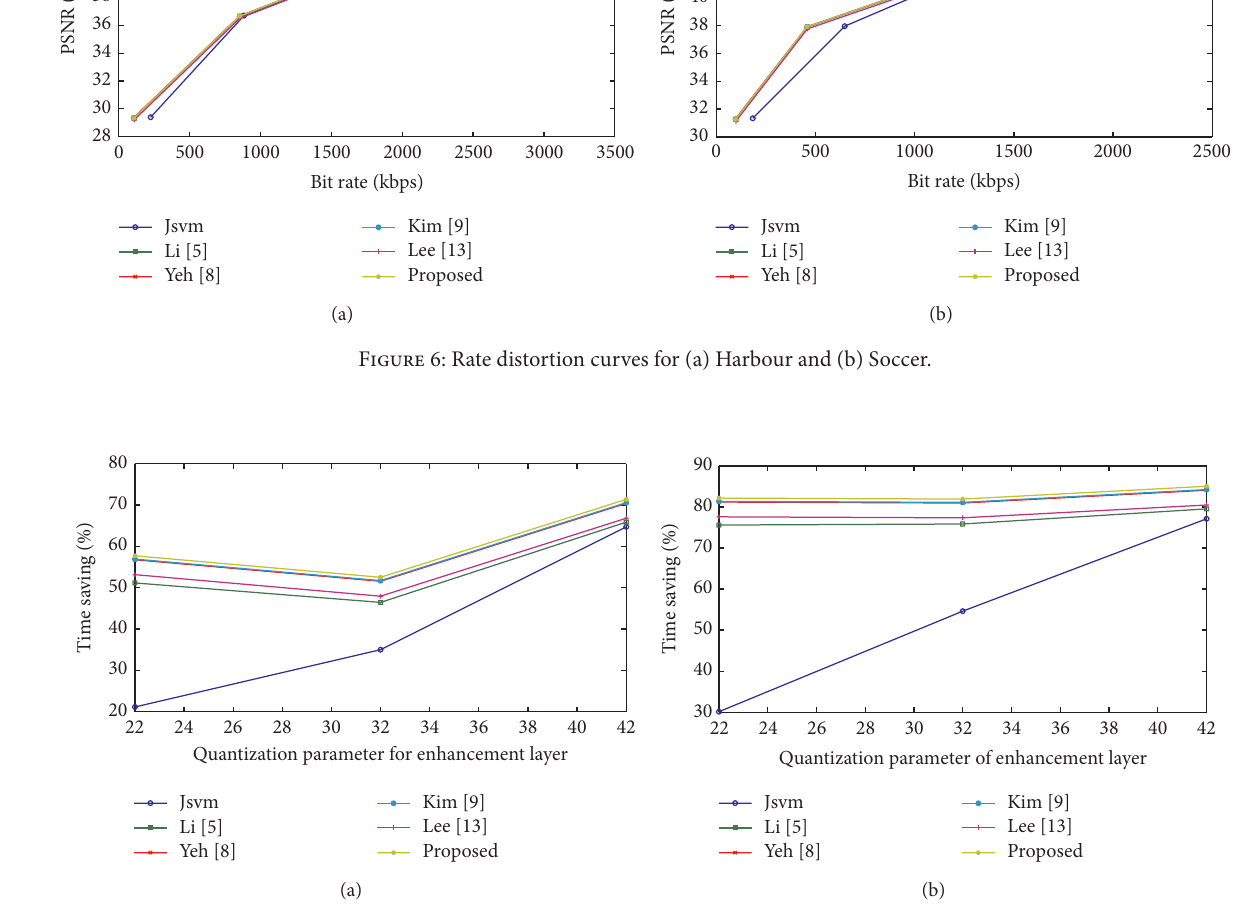
Figure 7: Time saving curves for (a) Football and (b)